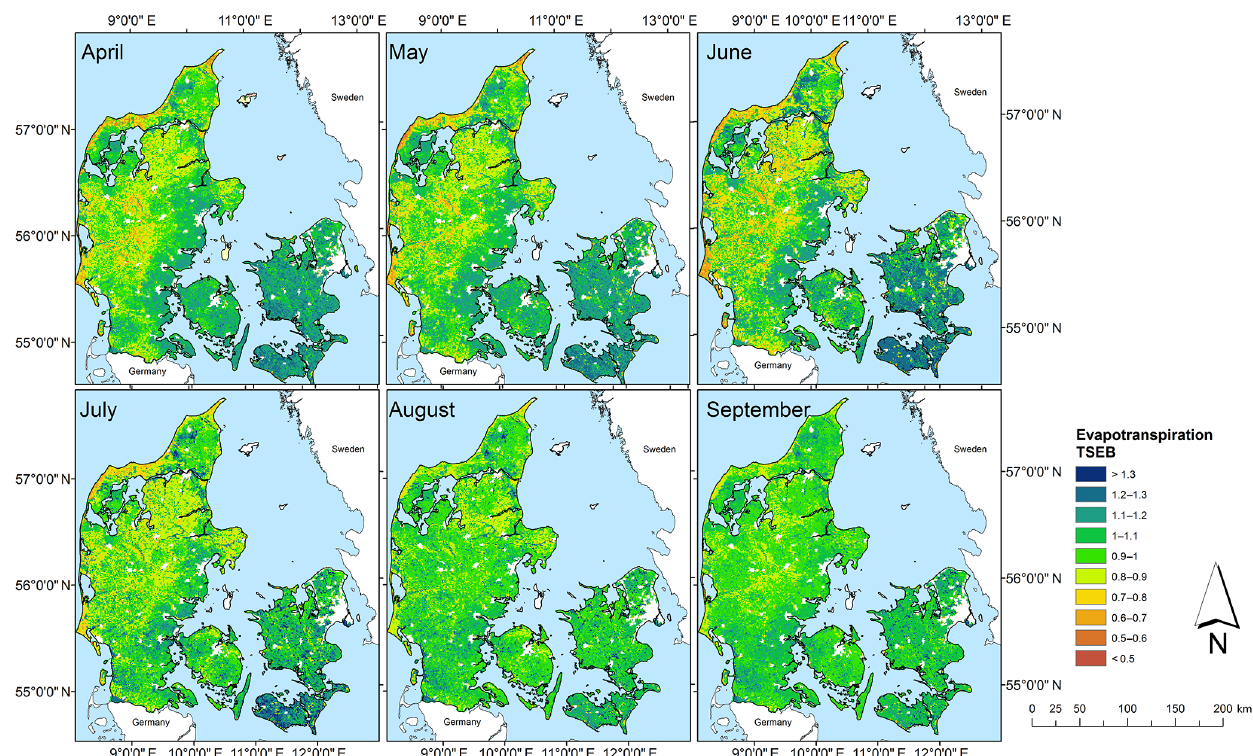
Figure 5. Monthly mean normalized TSEB ET maps (–) in which urban areas have been masked